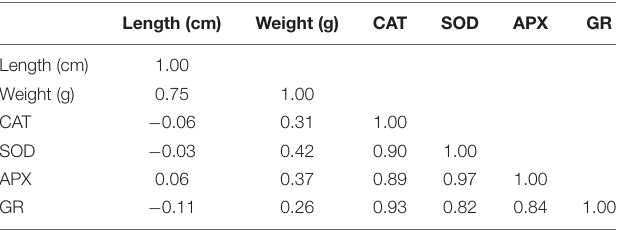
TABLE 4 | A correlation matrix exists between